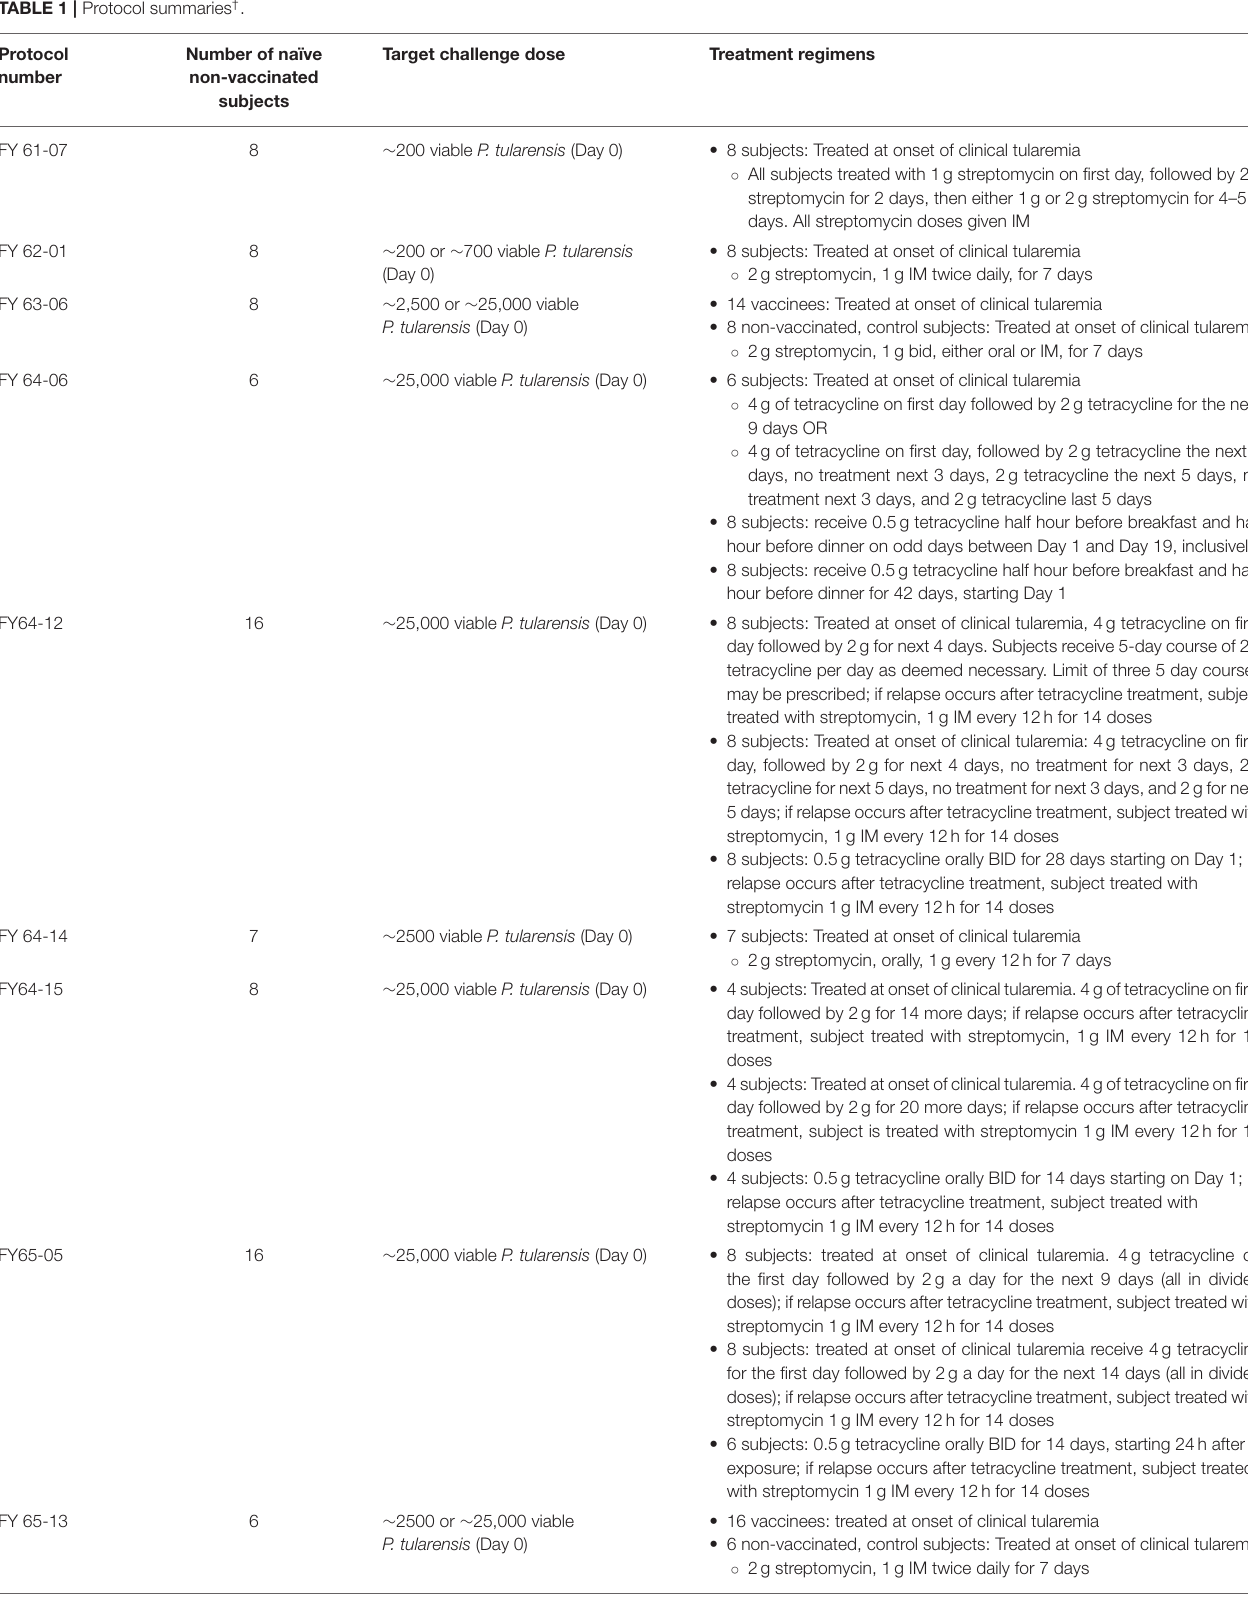
TABLE 1 | Protocol summaries † . Protocol